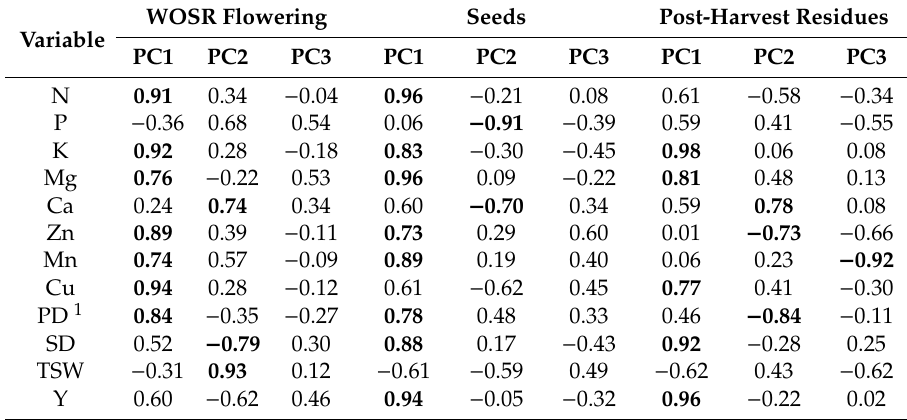
Table A2. Spearman correlation matrix between nutrient accumulation, yield components and PCA factors. WOSR Flowering Seeds Post-Harvest Residues Variable